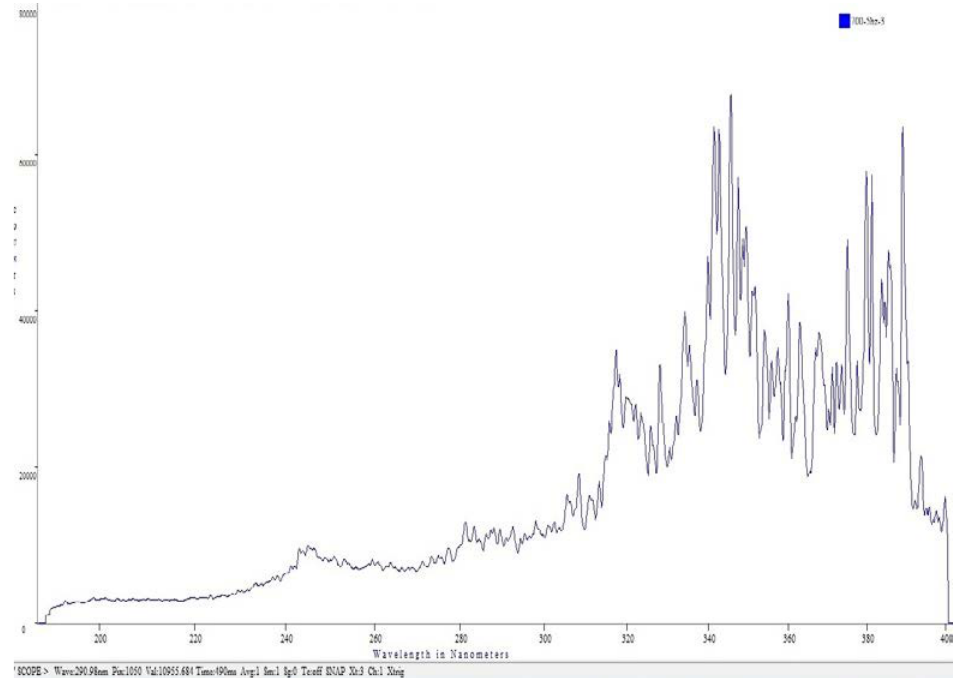
Fig.4: Emission spectra of laser energy 700 mJ with (1Hz) repetition